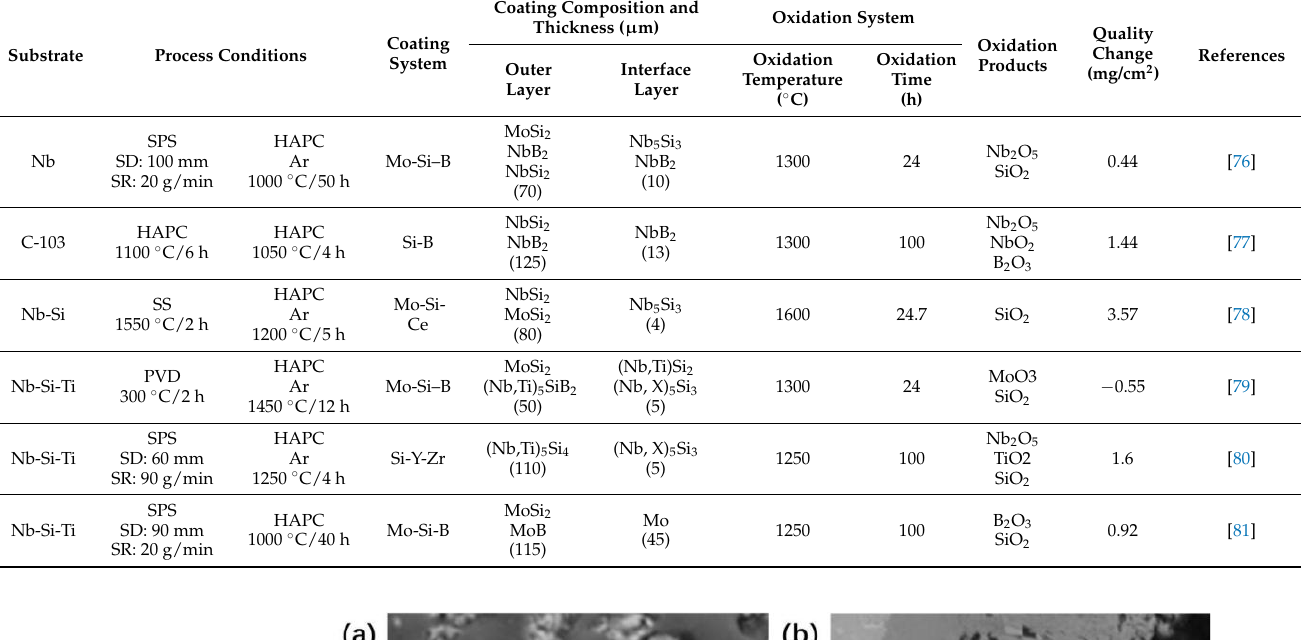
Table 4. Two-step coating preparation procedure and oxidation resistance details on Nb alloy surface.